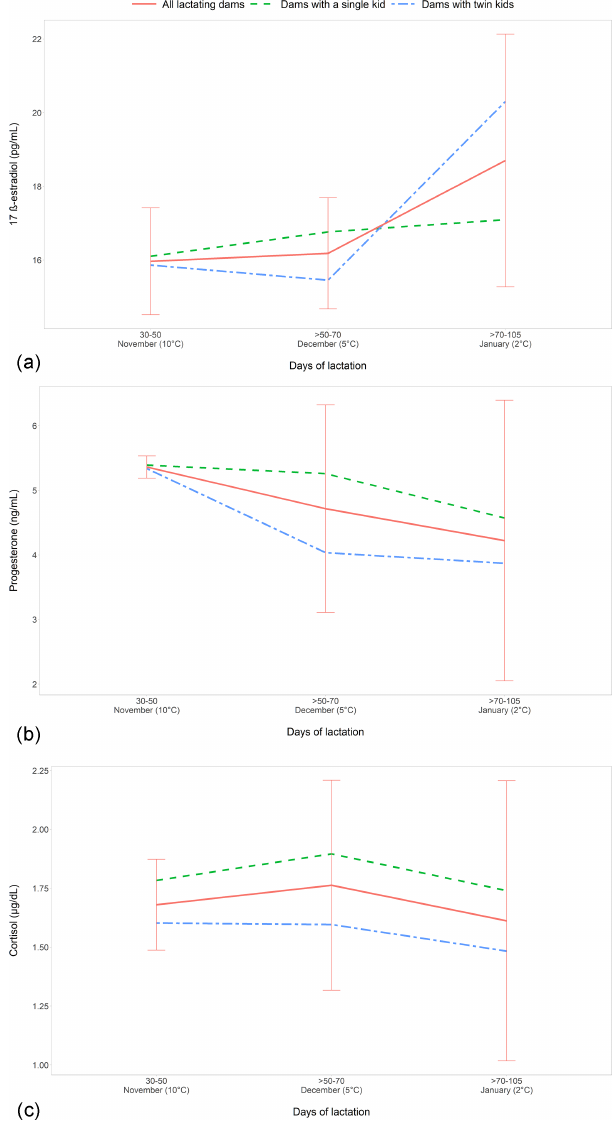
Figure 2. Circulating 17- β -estradiol (a) , progesterone (b) , and cortisol (c) concentrations (mean ± SD) in 30 lactating Nicastrese